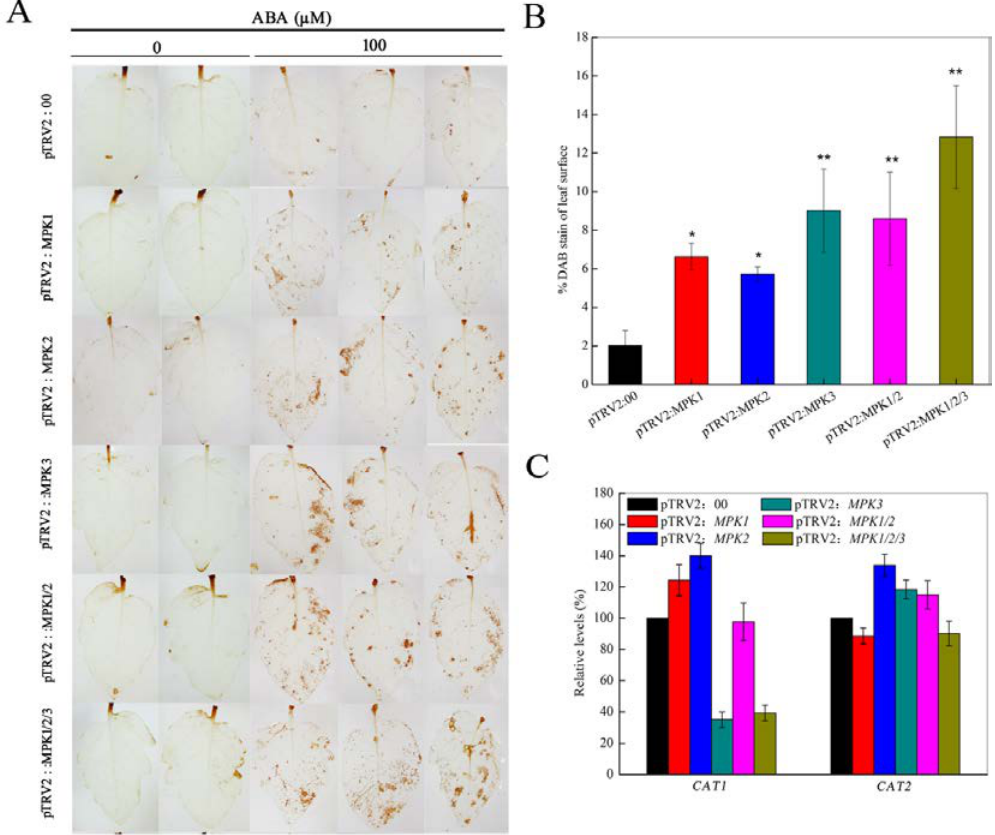
Figure 3. H O production and CATs transcription levels of gene-silenced 2 2